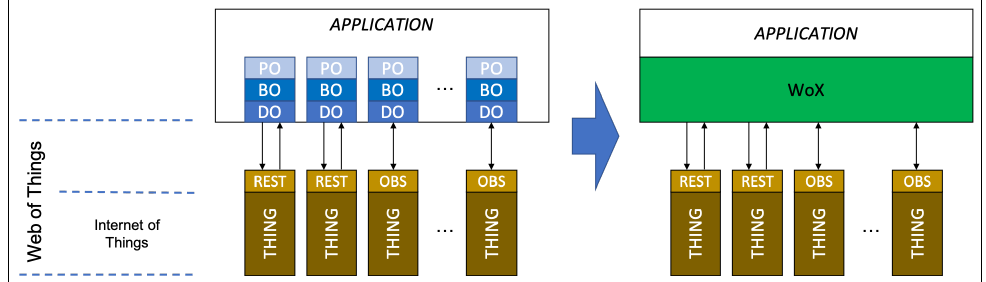
Figure 2. WoX reference model. WoX simplifies the Application layer as it wraps the specific Presentation Objects (PO), Business Objects (BO) and Data Objects (DO) for each (OBServable) thing. By this way, it reduces the application